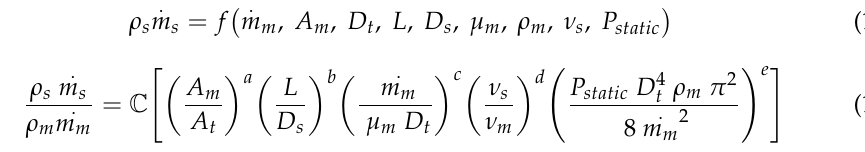
Figure 12. Suction ratio predicted by low and high suction ratio correlations vs. the suction ratio from the validated simulation.